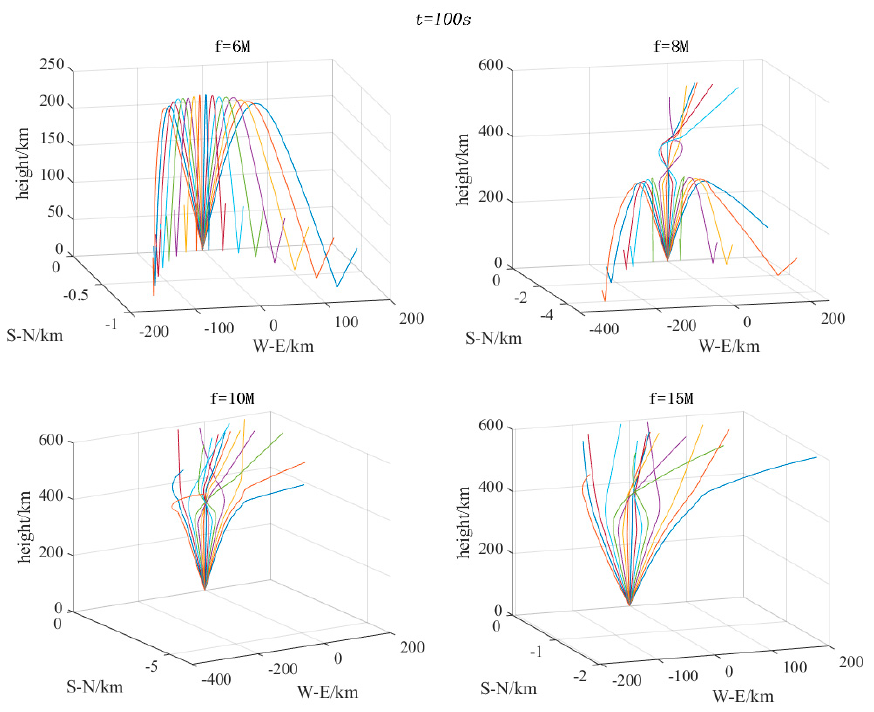
Figure 10. Propagation paths of HF shortwave at different frequencies after 100s release of CO 2.